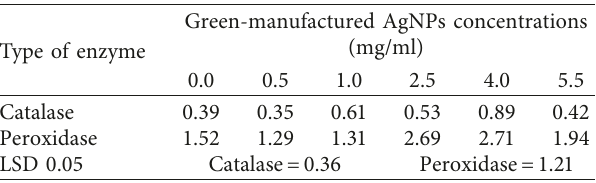
Table 6: Green-manufactured AgNP effects on proline and car- bohydrate concentrations, n �